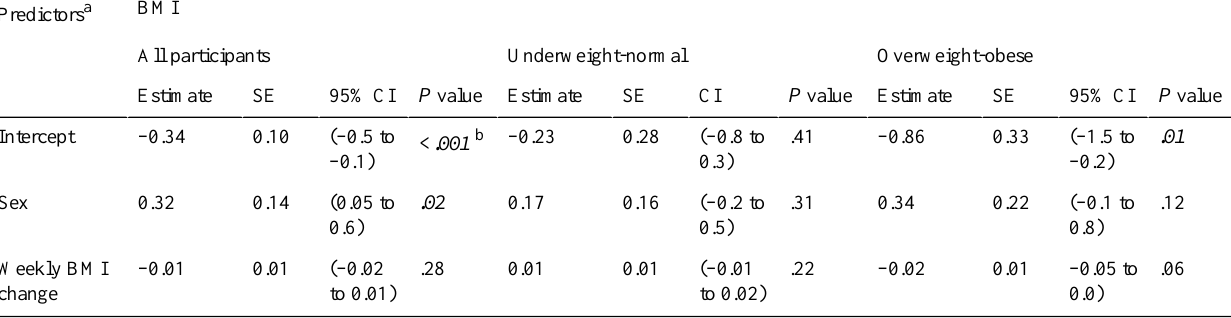
Table 3. Linear mixed effects analysis of the weekly BMI change of each